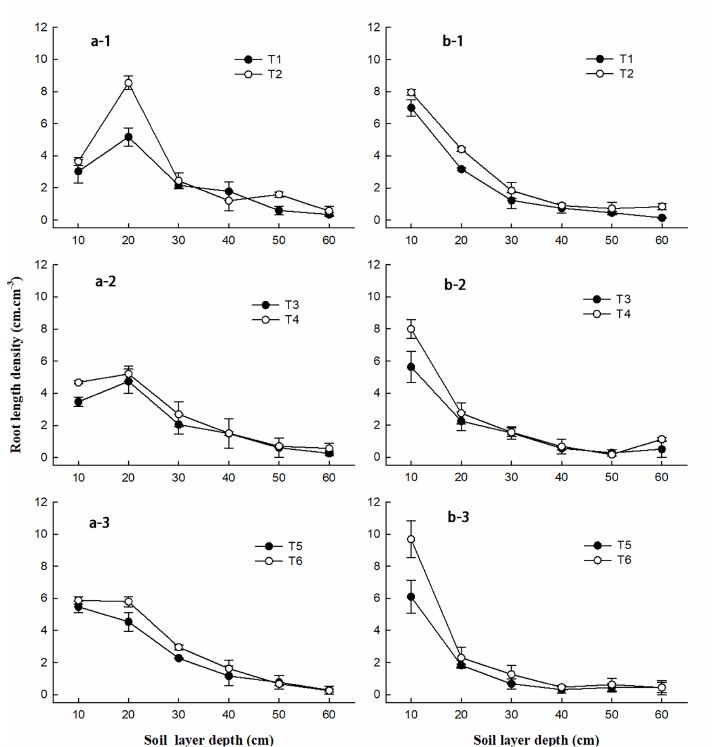
Figure 4. RLD under the effects of organic manure and planting densities. In this figure, ( a-1 ) repre- sents planting at a density of 60,000 plants/ha in 2011, ( a-2 ) represents "75,000 plants/ha in 2011", ( a-3 ) represents “90,000 plants/ha in 2011” , ( b-1 ) means “60,000 plants/ha in 2012”, ( b-2 ) means “75,000 plants/ha in 2012”, ( b-3 ) means “90,000 plants/ha in